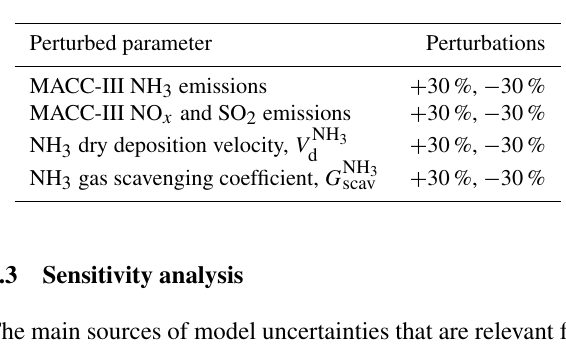
Table 2. Perturbations on input fields that have been used for the sensitivity analysis of the